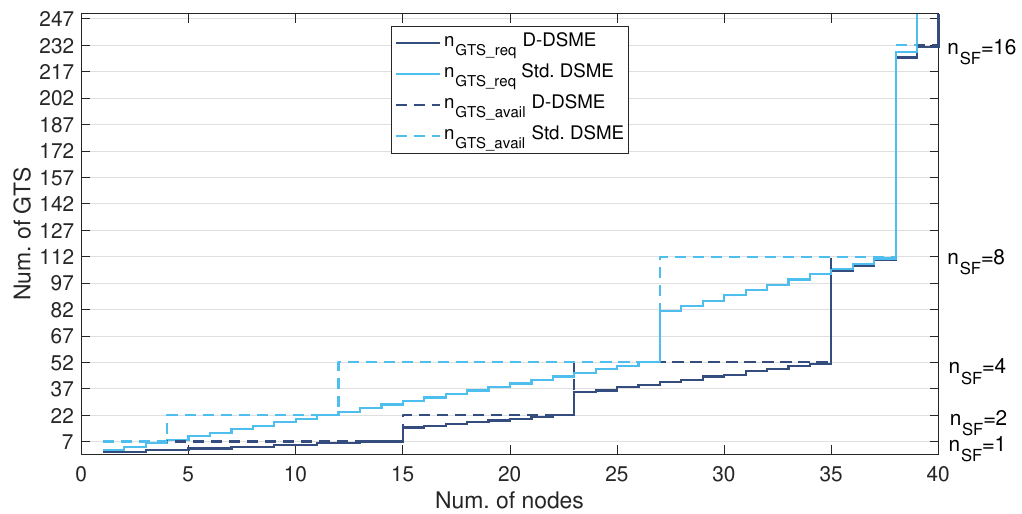
Figure 4. Superframes required to accommodate all